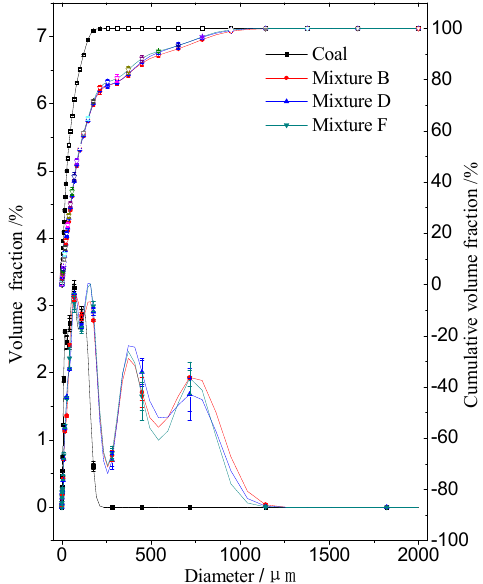
Figure 4. Size distributions of raw